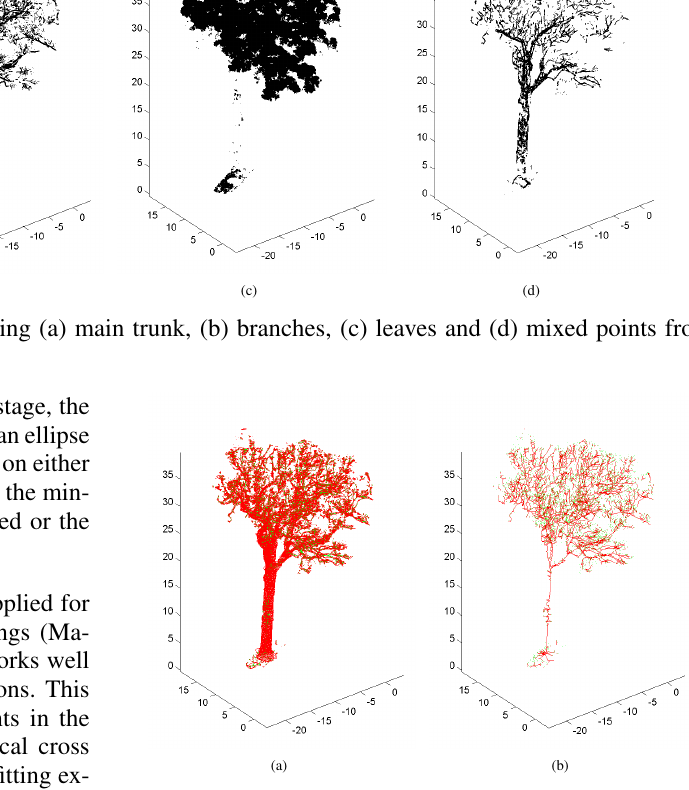
Figure 3: (a) tree represented by ellipses at vertical inter- vals, and (b) the tree represented by the extracted skeleton of ecosystems on climate change. A simple allometric for calculating the volume of trees is described in Dean and Wardell-Johnson (2010) and approximates the volume of the tree based on the diameter of the tree at breast height and the